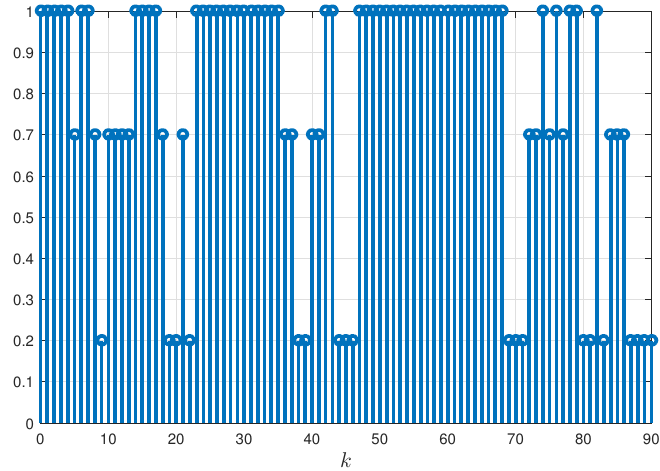
Figure 16. Failure